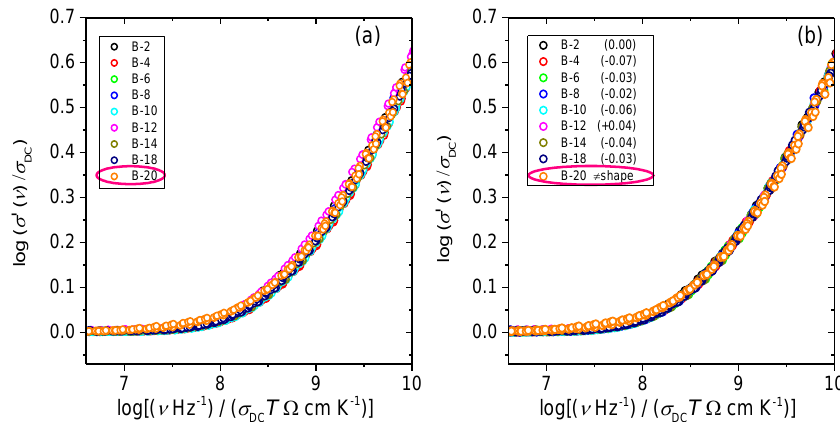
Figure 6. ( a ) Construction of super-master curve of the conductivity isotherms using the Summerfield scaling procedure for x B 2 O 3 –(100− x )[40Fe 2 O 3 –60P 2 O 5 ] glass series and ( b ) individual conductivity master-curves shifted along the x -axis.